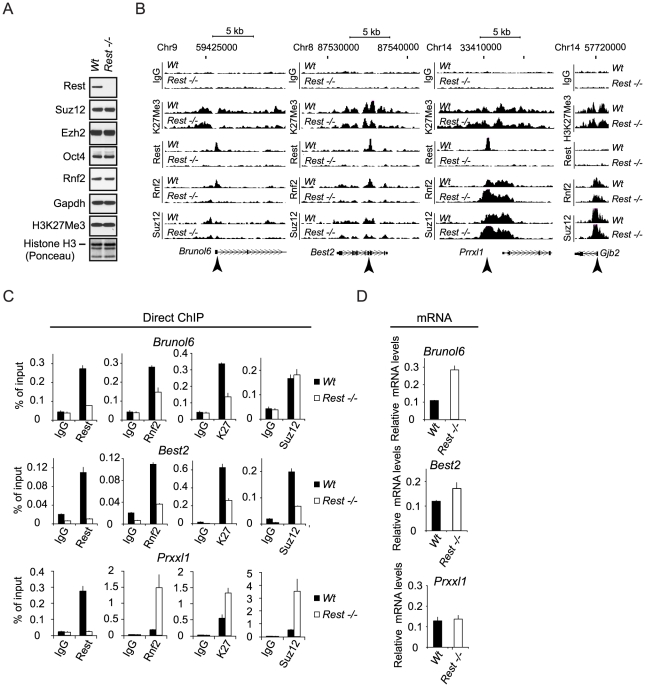
Rest regulates recruitment of PRC1 and PRC2 at specific genomic loci.(A) Western blot analysis of Wt and Rest−/− mES cell lysates. Histones were extracted using LSB. (B) ChIP-seq profiles for Rnf2, Suz12 and H3K27Me3 levels in Wt and Rest−/− mES cells for three Rest target genes (Brunol6, Best2 and Prrxl1) and as control, one Polycomb target gene with no Rest binding site (Gjb2). Direct ChIP for the three Rest target genes shown in (B) comparing Wt and Rest−/− mES cells (primer positions are indicated by arrow heads in B and K27 = H3K27Me3) and mRNA levels (C). Error bars represent standard deviations calculated from triplicate qPCR reactions.